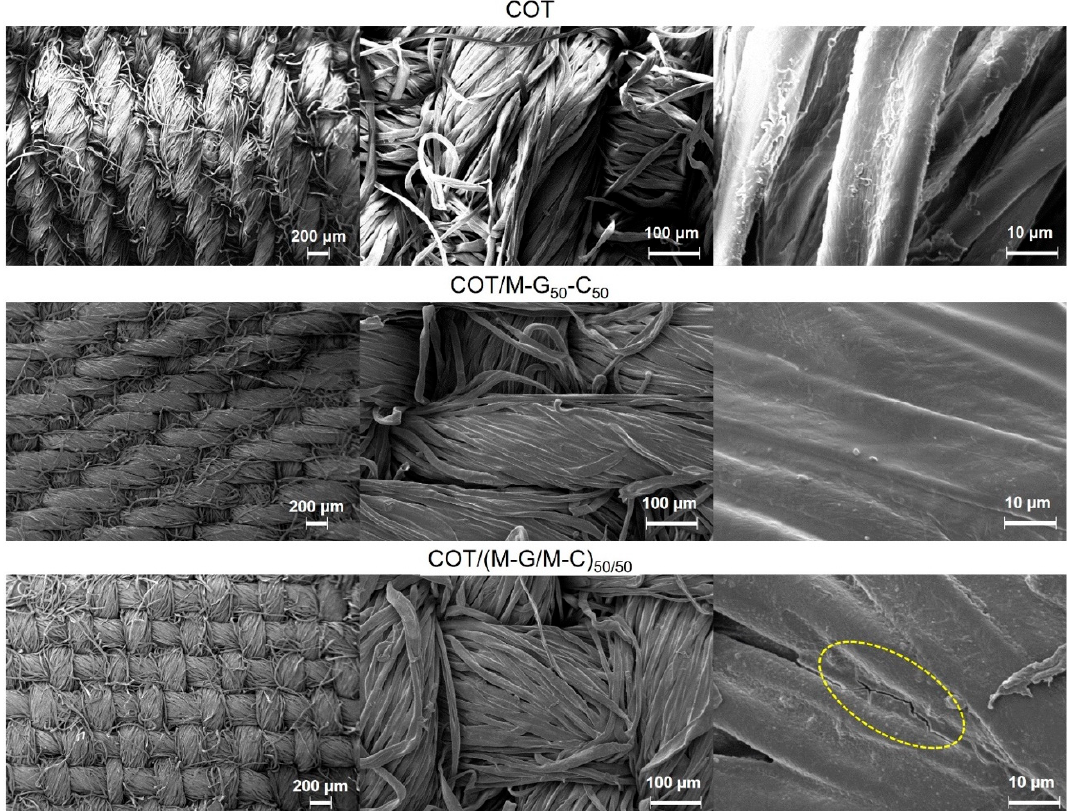
Figure 2. SEM micrographs of untreated-cotton fabric, and cotton fabrics treated with either M–G 50 –C 50 copolymer (add-on: 16.0%) or (M–G/M–C) 50/50 blend (add-on: 16.5%). The presence of cracks in the last panel is highlighted by a yellow ellipse. Polymers 2019 , 11 , x FOR PEER REVIEW